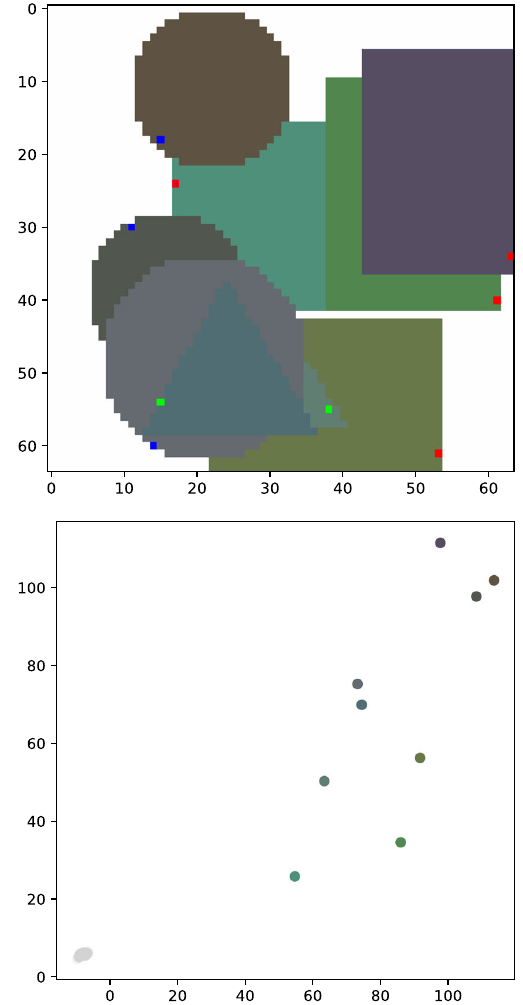
Fig. 2 Top: input image with prediction overlay. The representative pixels are highlighted, and their colour coding indicates the predicted classification: green (triangle), red (rectangle), blue (circle). Bottom: clustering space. The object colours are the same as in the top image, while the background pixels are coloured in gray. The alpha value indi- cates β , with a minimum alpha of 0.05, such that background pixels are visible 5 Application to particle